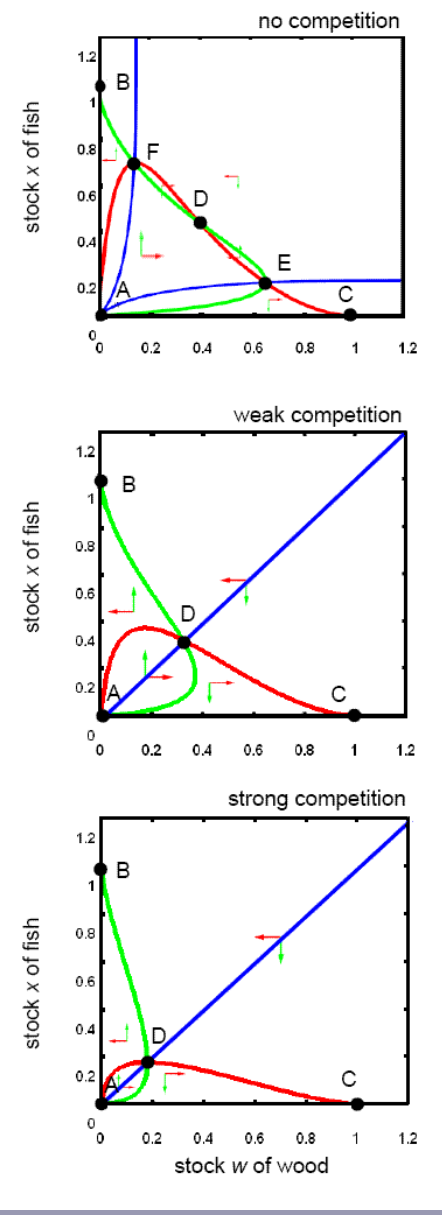
Fig. 6. Phase diagrams for the ecosystem's dynamics at a given level of resource complementarity and increasing interspecies competition, g i. Dynamics in each diagram are characterized by dx/dt > 0 (< 0) left (right) of the green line, and dw/dt > 0 (< 0) below (above) the red line. Blue lines indicate saddlepaths. The upper diagram displays the case of independent species ( g x = g w = 0). Competition occurs in the middle ( g x = g w = 0.25) and increases in the lower ( g x = g w = 1.25) diagram. Parameter values for all diagrams: r x = r w = 0.5, k x = k w = 1, n x = n w = 1, a = 0.6, s = 0.4, n =